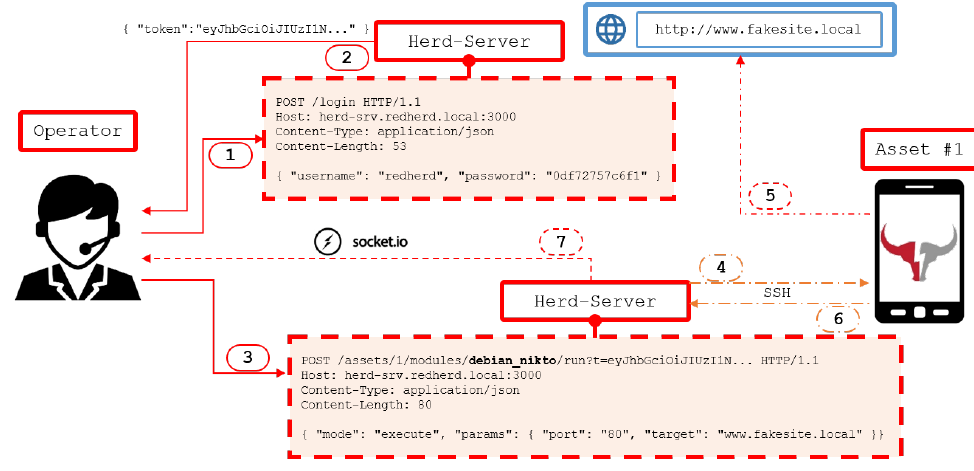
Figure 4. RedHerd tasking